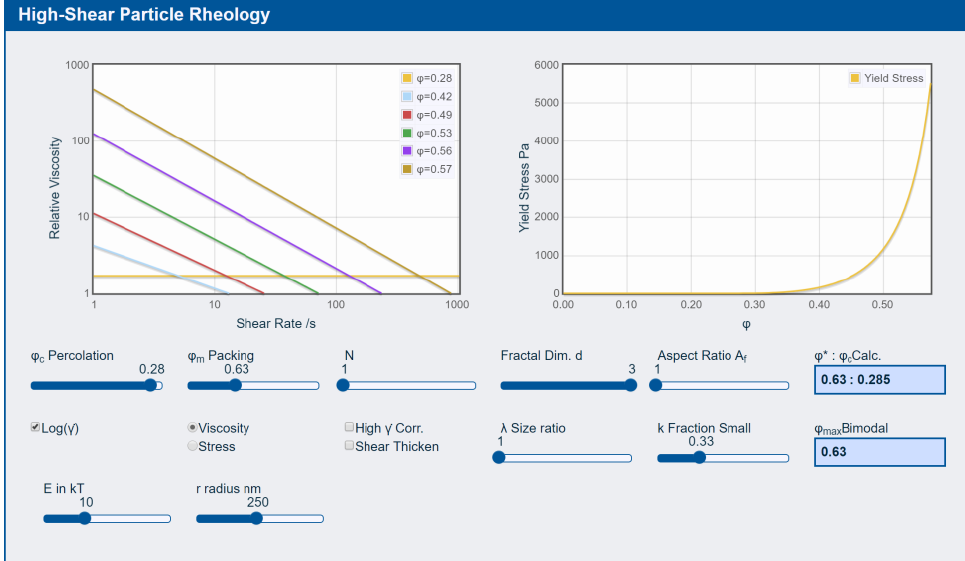
Figure 10. High shear-rate properties of relevance to printing. There are two critical phase volumes (percolation and packing), plus the effects of aspect ratio, plus the effect of fractal dimension—a surrogate for flocculation effects. The effects of particle radius on yield stress are included. The equations are too complex to show here but are fully described in the app, which is at www.stevenabbott.